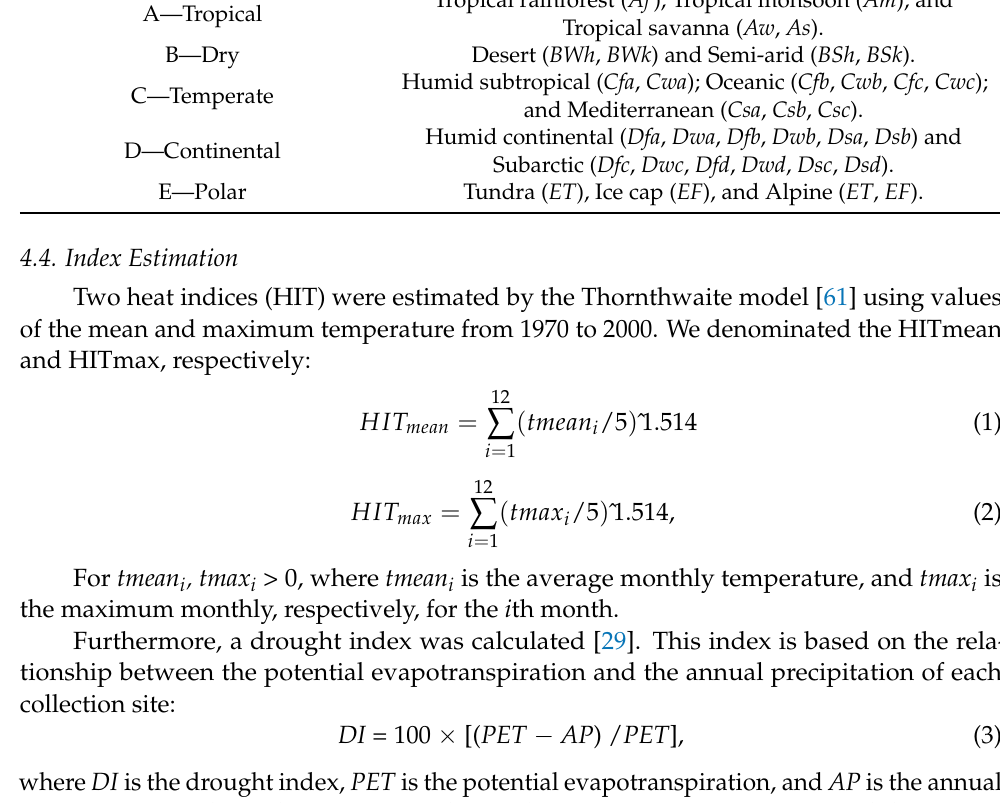
Table 8. Climate types under the Köppen-Geiger climate classification. Group Climates A—Tropical Tropical savanna ( Aw , As